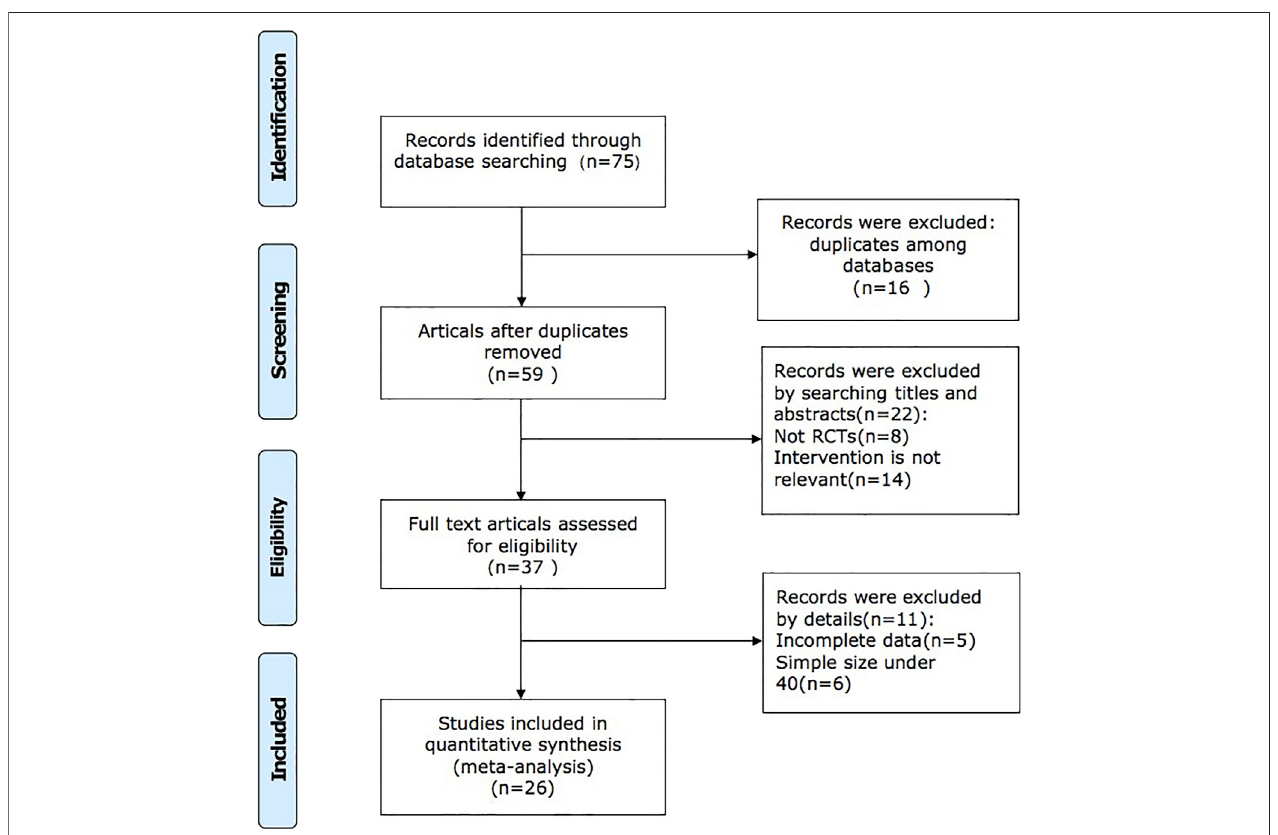
FIGURE 1 | Flow diagram of study selection and identi fi